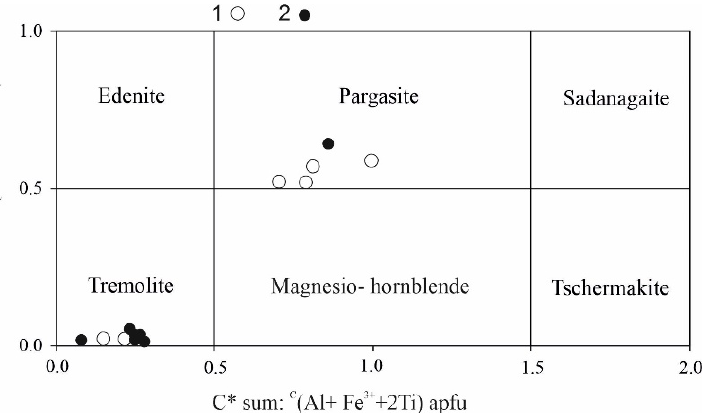
Figure 3. Classification diagram of clinopyroxenes [49]. 1—sample M-1; 2—sample M-8; 3—sample M-9.